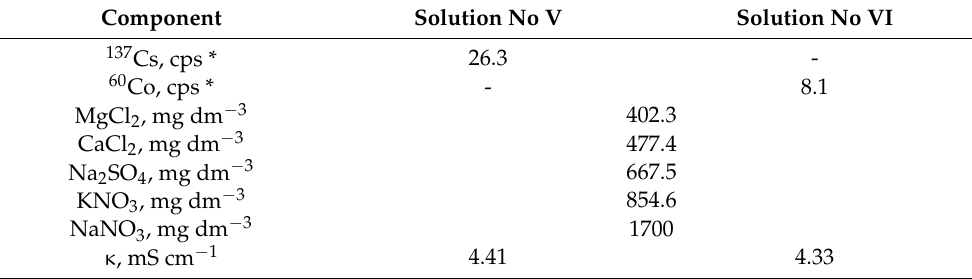
Table 5. Characteristics of the radioactive model solutions.